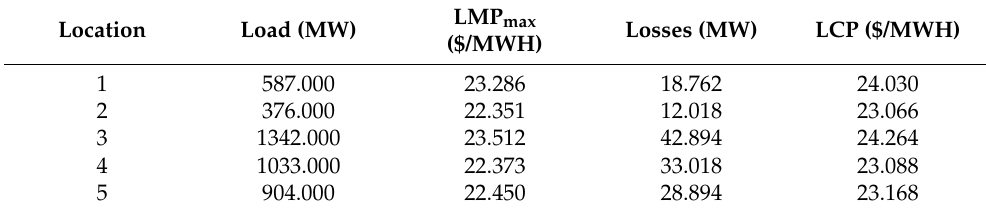
Table 10. LMP, Losses, and Consumer Prices for a Large-Scale